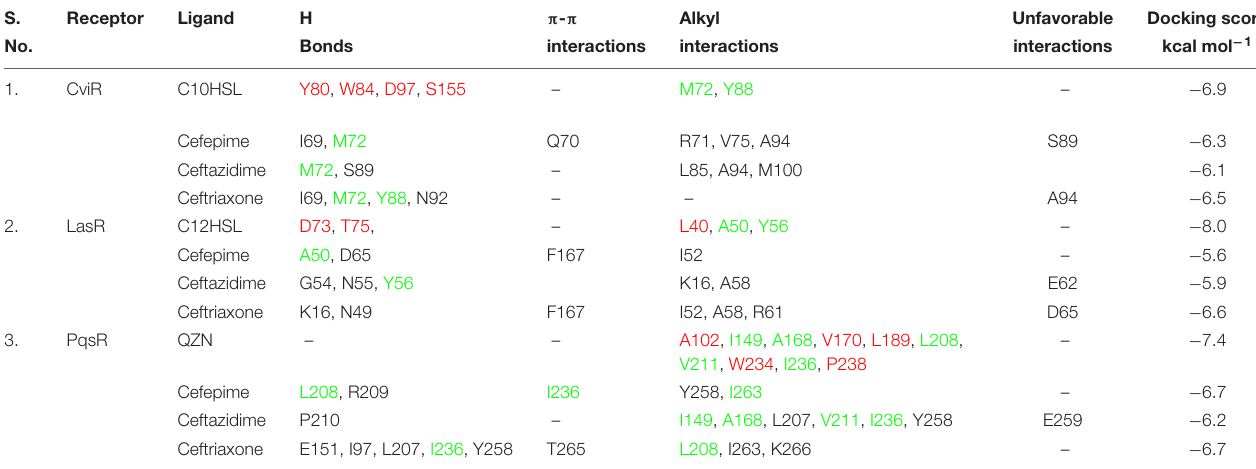
TABLE 1 | Comparative analysis of molecular interaction of natural ligands and antibiotics with receptor proteins.